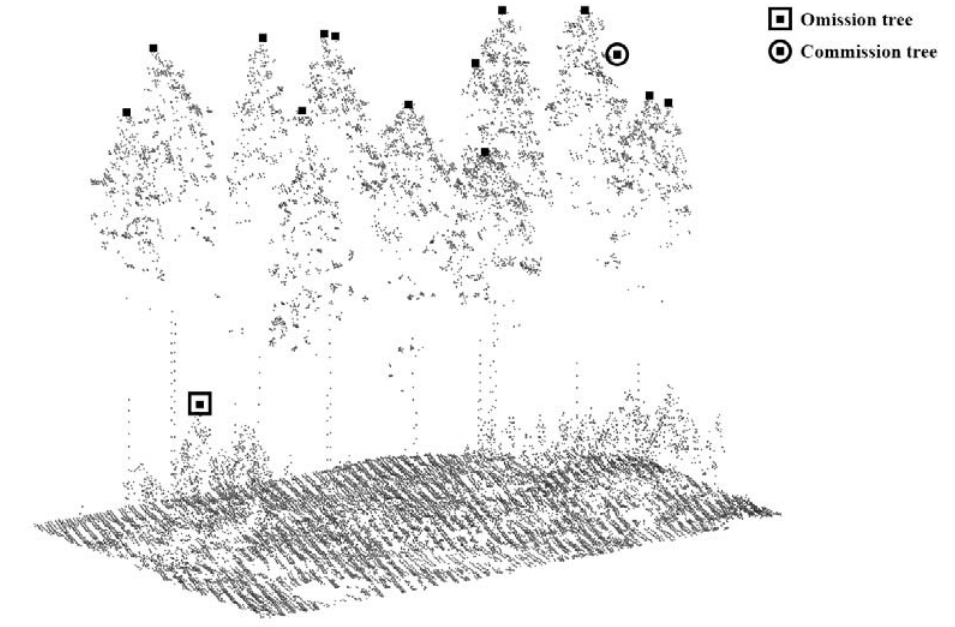
Figure 2. ITD -detected trees plotted with black solid squares. Omission tree marked auto (shallow black square) from understorey. Commission error from plot with a single tree (shallow black circle) is easily reduced in visual